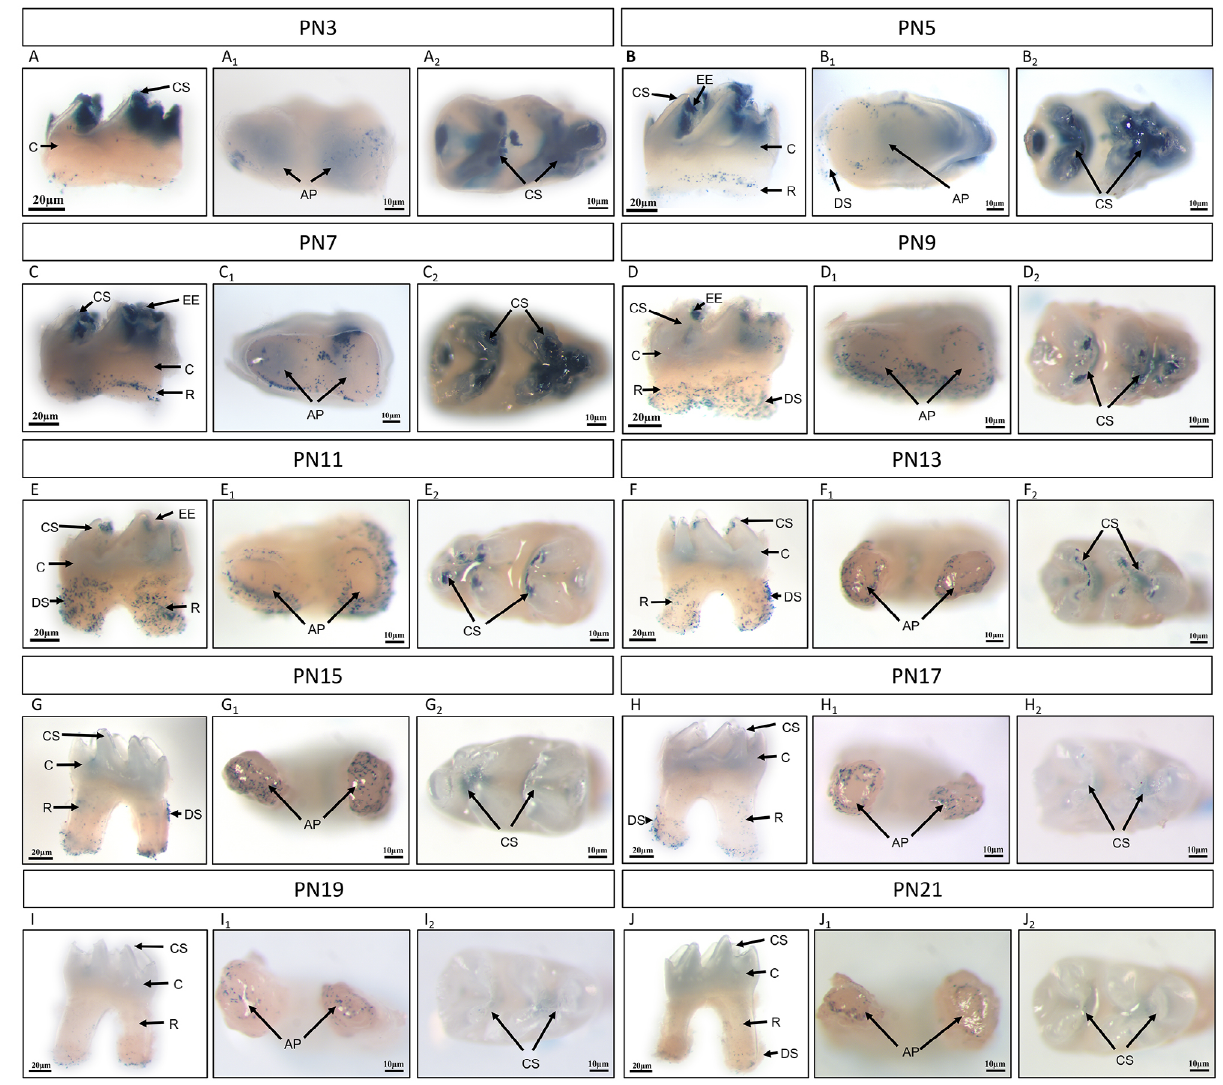
Figure 2- BAT-gal reporter activity during M1 postnatal development in mice ranging from PN3 to PN21. A whole-mount X-gal staining of M1 showed Wnt/β-catenin signaling in the buccal/ lingual view (A, B, C, D, E, F, G, H, I, and J), in the apical view (A1, B1, C1, D1, E1, F1, G1, H1, I1, and J1), and in the occlusal view (A2, B2, C2, D2, E2, F2, G2, H2, I2, and J2). On PN3 and PN5, active Wnt/β-catenin signaling was detected in the mesenchyme directly below the cusps (A–B) (A1–B1) (A2–B2). On PN7, active Wnt/β-catenin signaling was observed in the apical region, with a decrease in the area below the cusps (C–C2). During PN9–PN14, strong Wnt/β-catenin signaling was observed in the root-forming regions not in the crown, and more specifically in the apical papilla and root sheath (D–F) (D1–F1) (D2–F2). From PN15 to PN21, the expression of Wnt/β-catenin signaling was diminished mostly, but some expression was observed in the apical region (G–J) (G1–J1) (G2–J2). (EE, enamel epithelium; DS, dental sac; CS, cusp; C, crown; R, root; AP, apical papilla; P, pulp; CL, cervical